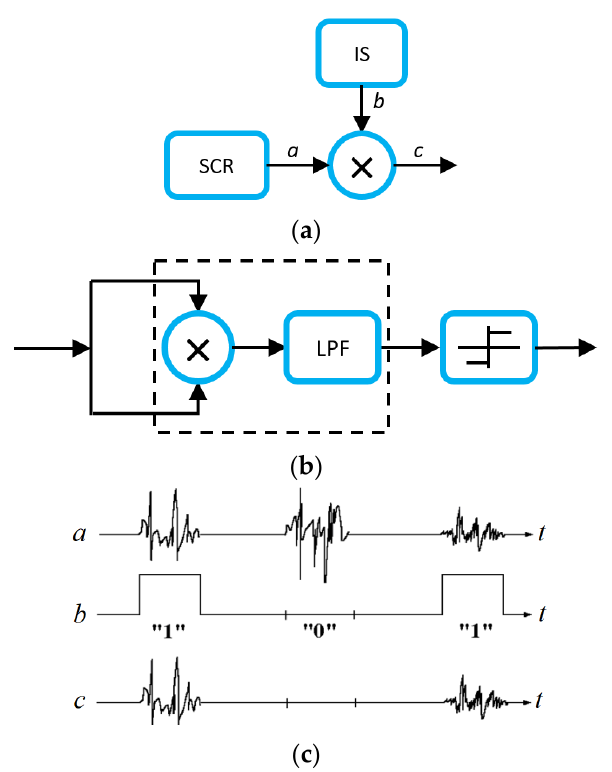
Figure 1. Simplest variant of DCC scheme: ( a ) transmitter, SCR—source of chaotic radio pulses, IS— information sequence; ( b ) receiver, where LPF—low pass filter; ( c ) signal waveforms in various nodes of transmitter.